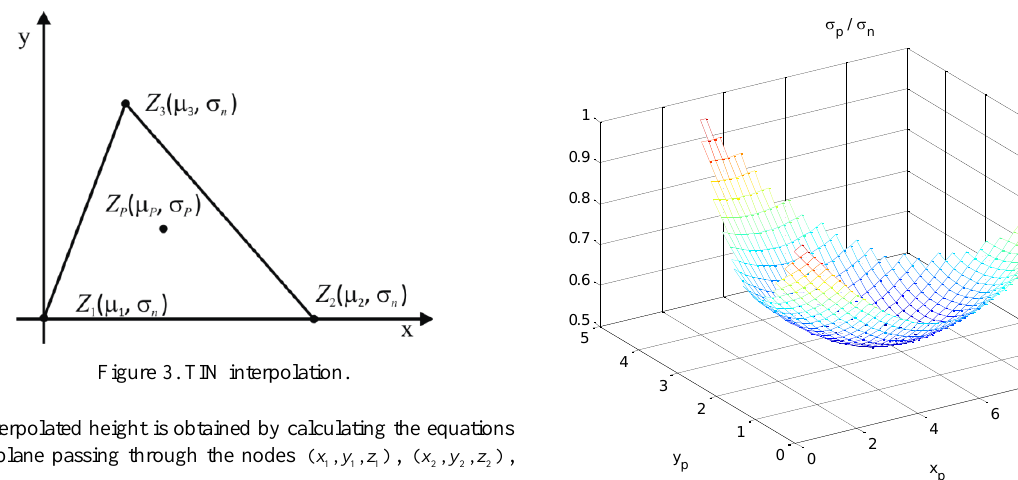
0 Figure 4. Plot of the ratio x y , for   as a function of   , P n P P TIN interpolation. In order to produce the plot, the triangle having vertices (0,0) , (10,0) and (3,5) was set, but the function's shape is independent from that.